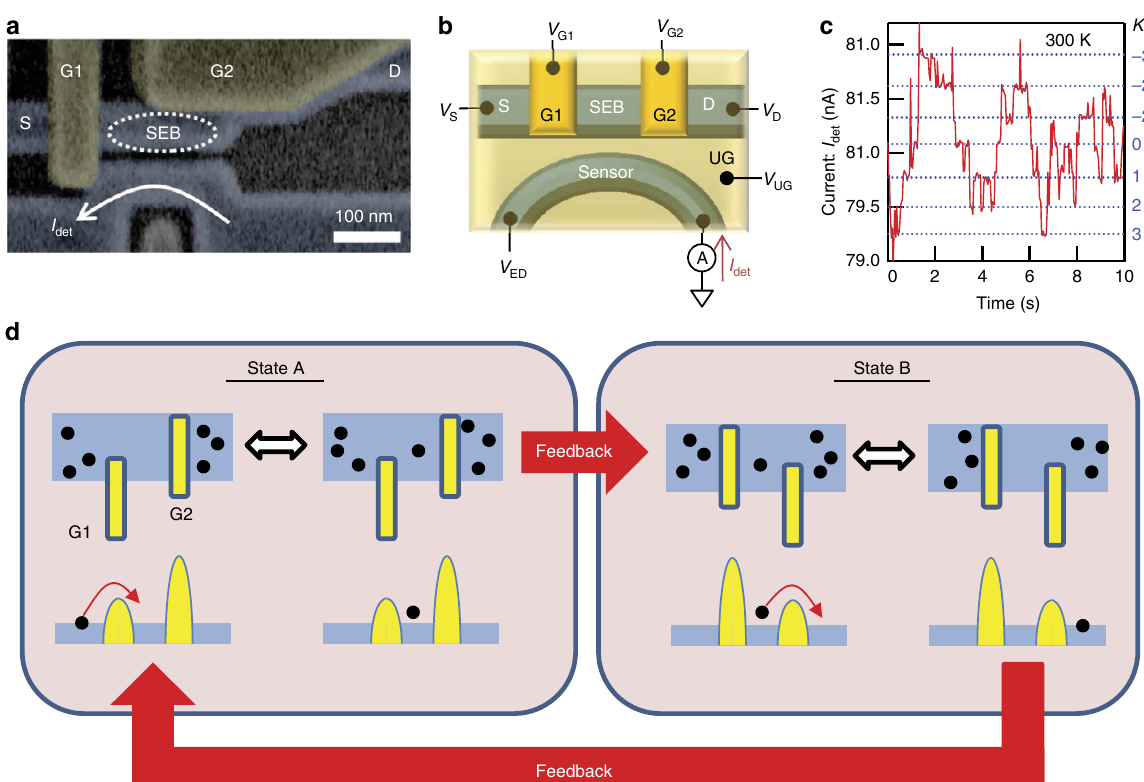
Figure 1 | Device structure and operation schematics for Maxwell’s demon. ( a ) False-color scanning electron microscope image and ( b ) schematics of the fabricated device. Above a silicon wire channel covered with a silicon dioxide, two gate terminals are formed to make field-effect transistors Gate(G) G1 and G2. The single-electron box (SEB) is electrically formed between the source (S) and drain (D) because G1 and G2 form energy barriers between the S and D as shown in d . Another channel functioning as a charge sensor is located close to the SEB. Above the whole area, there is an upper gate (UG), to which positive voltage V UG is applied. The details are explained in Methods section. ( c ) Single-electron detection at room temperature. Current flowing through the sensor is monitored and the abrupt reduction (increase) of current with the same step height means that a single-electron enters (leaves) the SEB. k is the deviation from the average of the number of electrons n in the SEB. We applied V UG ¼ 3.05V, V ED ¼ 1V, V G1 ¼ (cid:3) 2.4V, V G2 ¼ (cid:3) 1.95V and V S ¼ V D ¼ (cid:3) 0.6V. ( d ) Schematics of current generation by rectifying randomly moving electrons. The four upper and lower illustrations are schematics and energy-band diagrams along the S, SEB and D, respectively. For simplicity, they show how one electron is transferred, meaning D n explained in the main text is one. We define state A(B) as the case that G1 opens (closes) and G2 closes (opens). When G1 opens (closes), its energy barrier lowers (rises) and an electron shuttles between the S and SEB faster